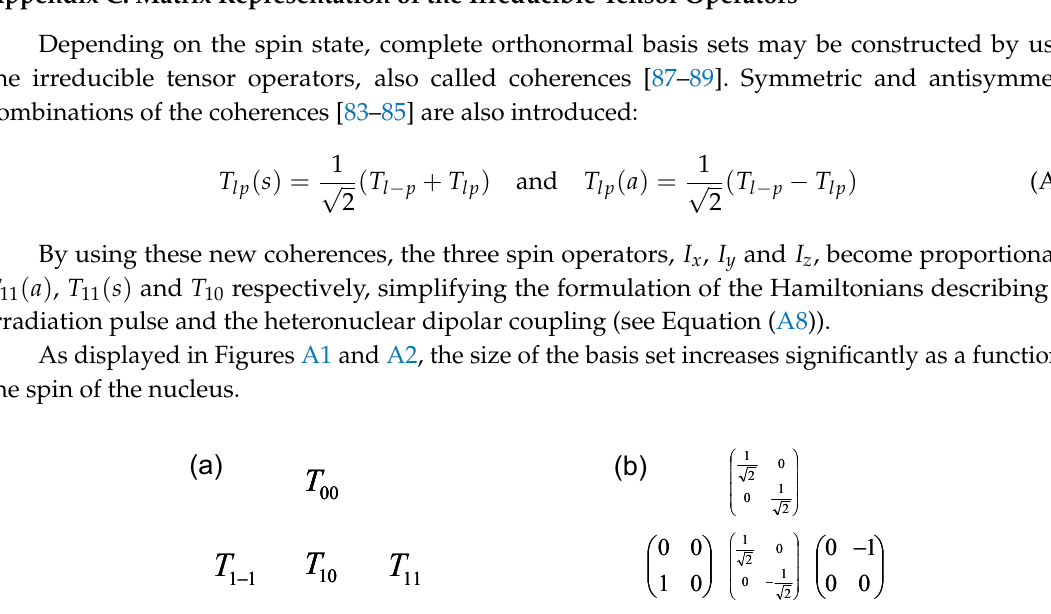
Figure A1. Complete orthogonal basis set (four elements) describing the evolution of the spin I = 1/2 (Pauli matrices): ( a ) symbolic representation T ij ; ( b ) explicit matrix representation of irreducible tensor operators.